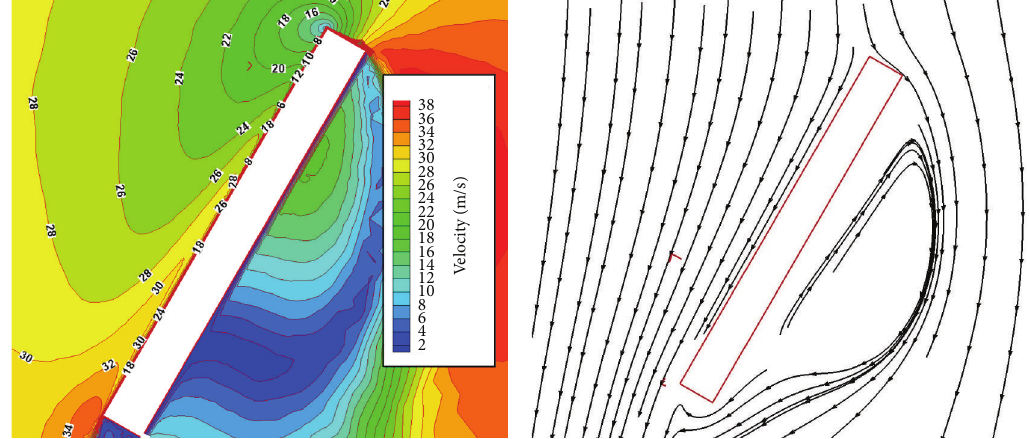
Figure 4: Flow velocity contours and path lines of the surface region of smooth